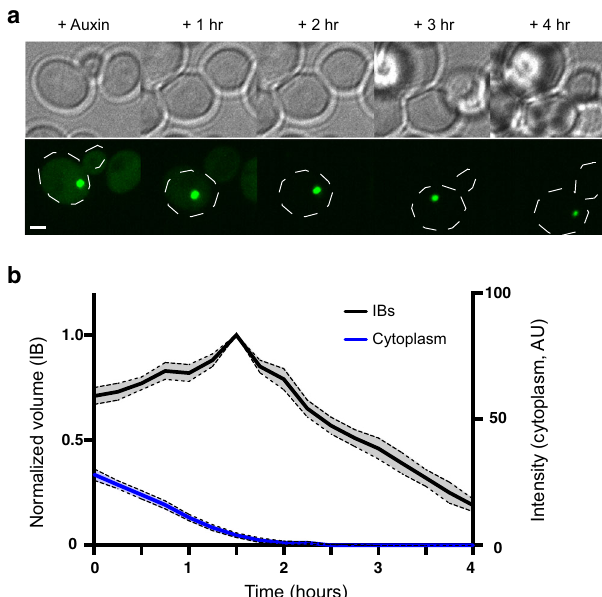
Fig. 4 Mutant Htt inclusion bodies shrink when cytoplasmic mHtt levels drop to low levels. a Time-lapse images of cells expressing Tir1 and mHttex1-degron-GFP were acquired immediately after the addition of NAA, and every 15 min for 4 h thereafter. Bright fi eld images (upper panels) and maximum-intensity projections of the GFP channel (lower panels) were taken shortly after the addition of auxin, then 1, 2, 3, and 4 h later, illustrating the loss of cytoplasmic GFP followed by decline in inclusion body (IB) size. The displayed contrast of the fl uorescence images is identical across the timecourse. The cell boundary is indicated by a dotted white line. Scale bar, 2 μ m. b Quantitation of average IB volume (black) and cytoplasmic intensity (blue) over time. Volume traces were normalized to the maximum for each IB, and aligned in time so that the maximum intensity of each individual IB occurs at the same time point ( n = 7 – 19 cells per timepoint; shaded regions indicate